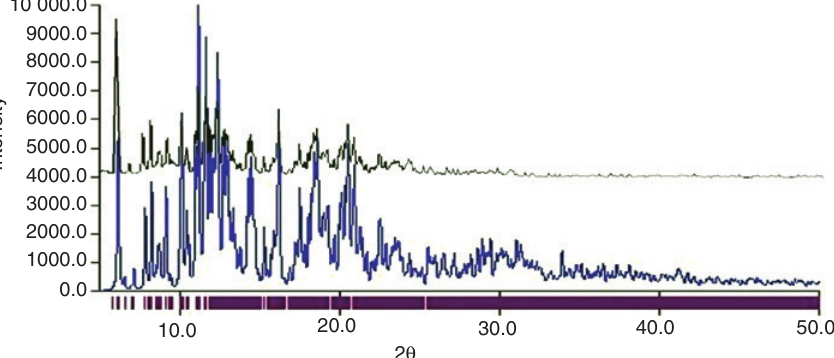
Figure 7: The powder X-ray diffraction patterns of PDTP.